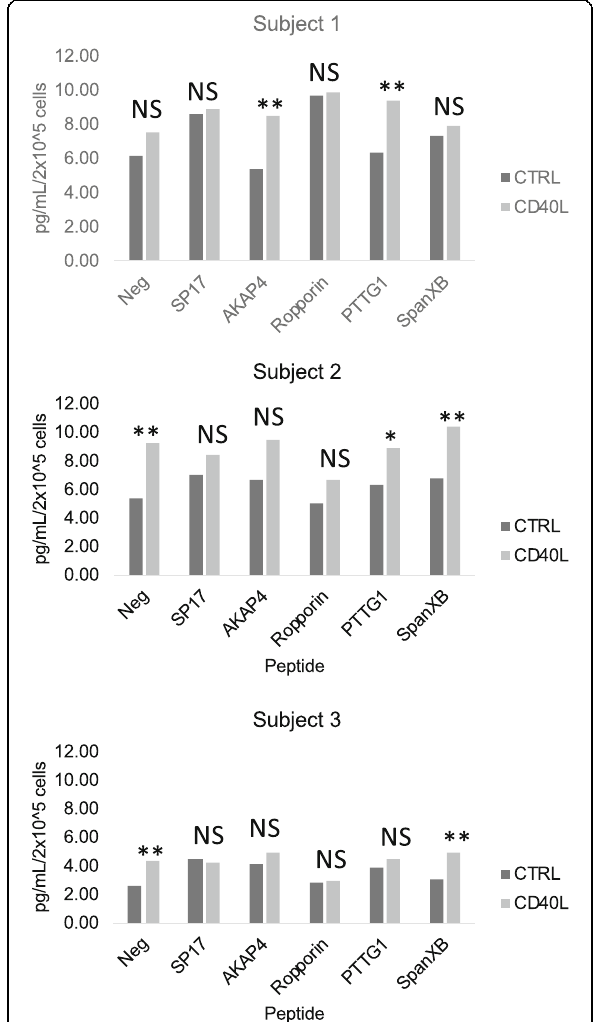
Fig. 4 Production of IL12p70. The DC activation marker, IL12p70, was measured by ELISA with or without CD40L stimulation. Histograms show the average IL12p70 level measured in the mDC medium in triplicate. For each peptide stimulation, a two- way t test (alpha = 0.05) was performed to compare the